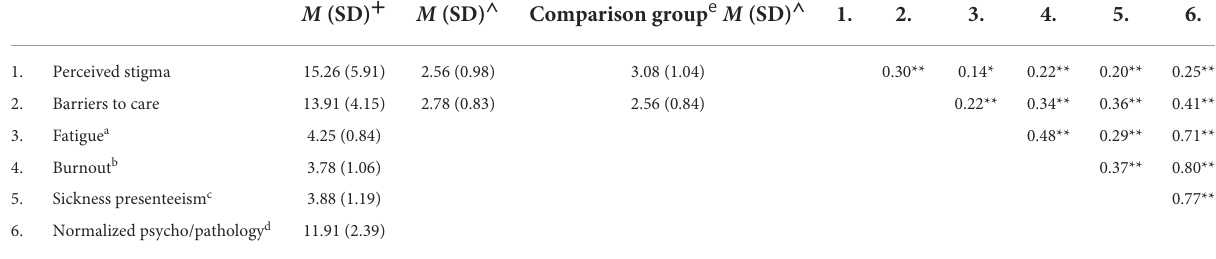
TABLE 2 Descriptive statistics and correlations of continuous